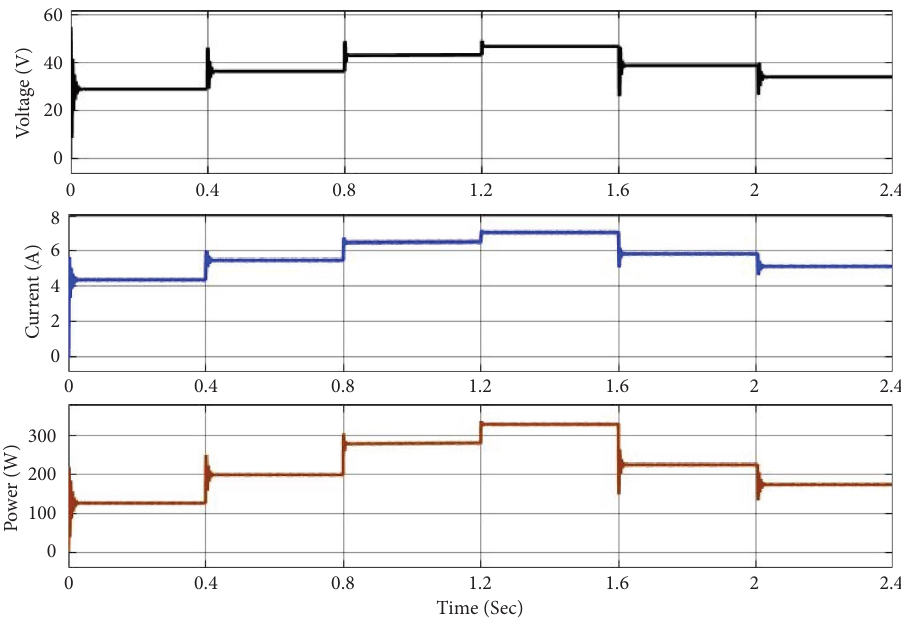
Figure 18: Input voltage, current, and power at